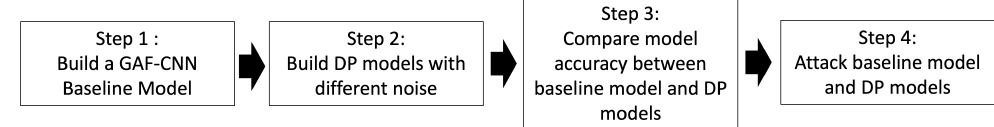
Figure 6. Experiment